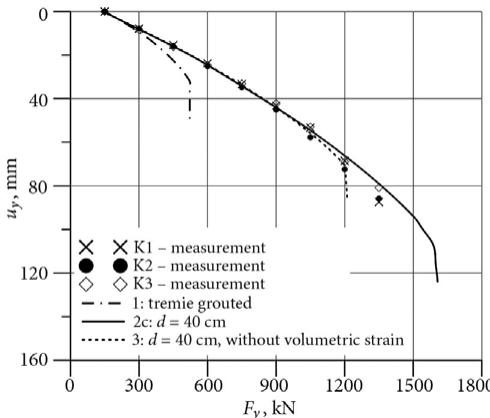
Fig. 12. Influence of the applied volumetric strain